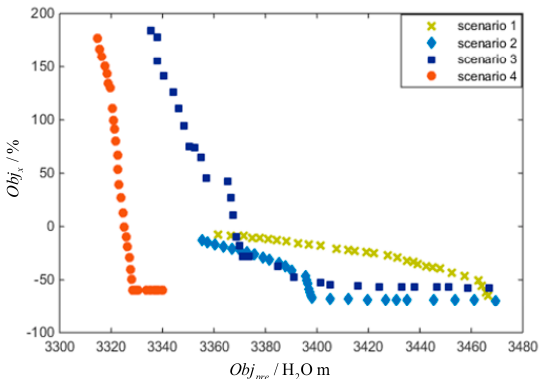
Figure 11. The Pareto front obtained of EMOBCGSA by different scenarios under pump outage conditions. Table 8. The detailed Pareto optimal schemes obtained of EMOBCGSA by different scenarios under pump outage conditions.